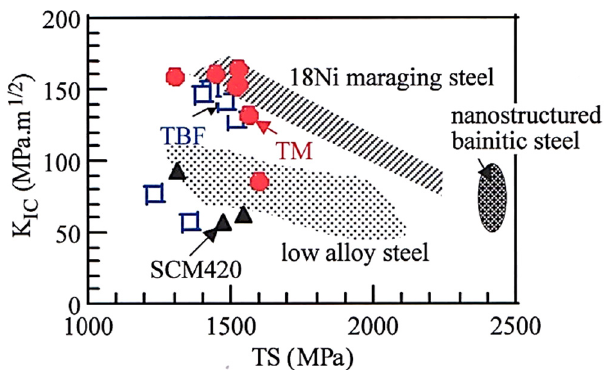
Figure 10. Relationship between fracture toughness (K IC ) and tensile strength (TS) [92] in 0.2%C–